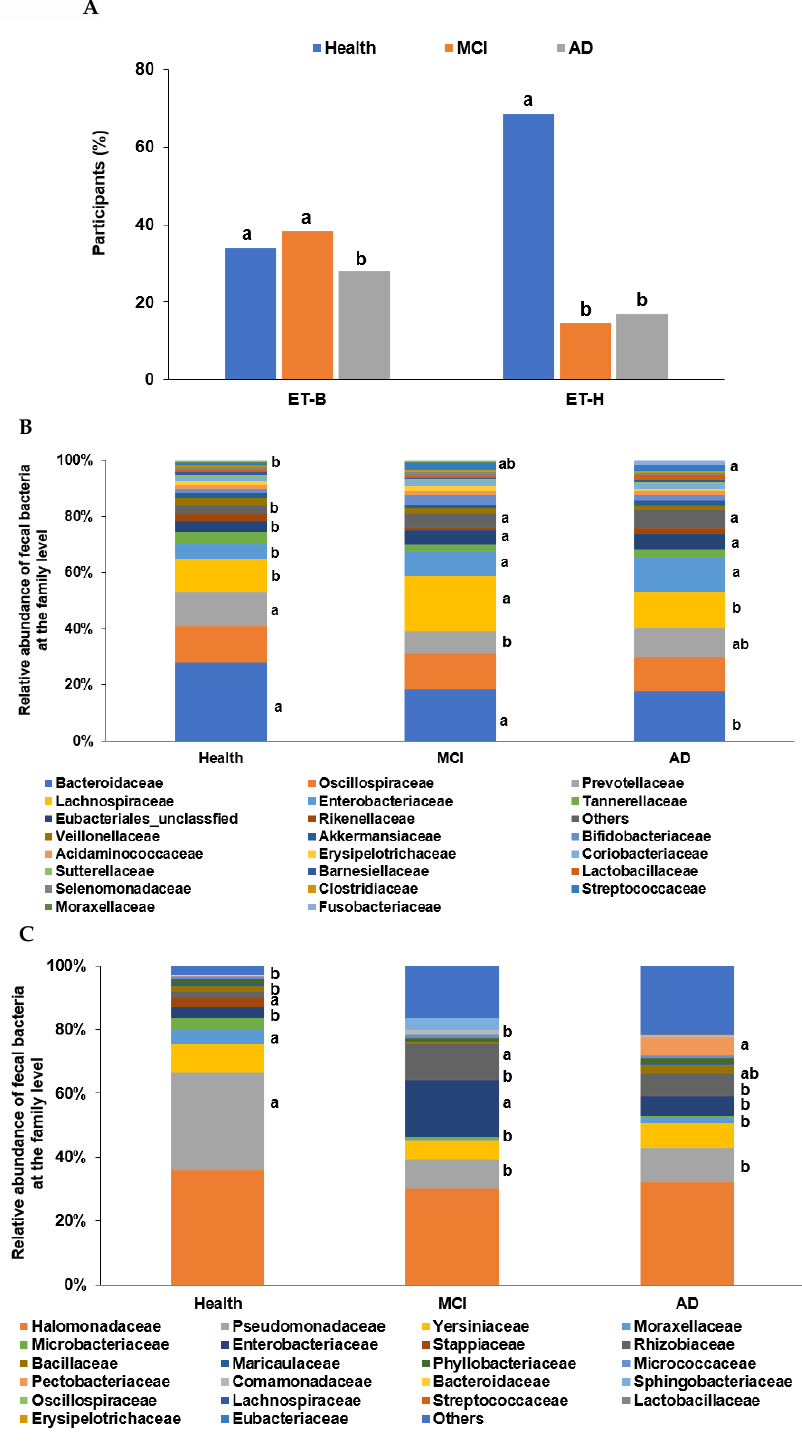
Figure 1. Characteristics of the gut microbiota from the human fecal bacteria of all participants. ( A ). Relative abundance of the fecal bacteria at the family level in the enterotype Bacteroides. ( B ). Relative abundance of the fecal bacteria at the family level in the enterotype Halomonas (ET-H). ( C ) The participants, according to enterotype Bacteroides (ET-B) and ET-H. a,b Different letters on the bar indicated significant differences among the groups at p <